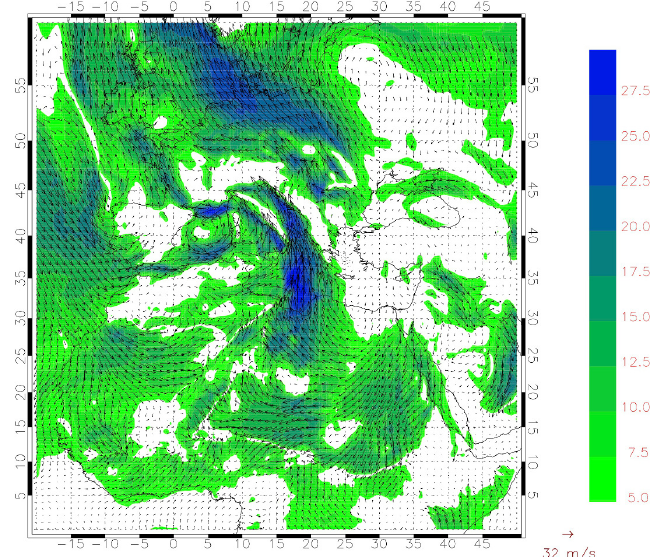
Figure 11. Wind speed (shaded contours; m/s) and direction (vector) at 925 hPa, at 00 UTC on 23 April 2019. The maps are generated using Copernicus Climate-Change Service Information